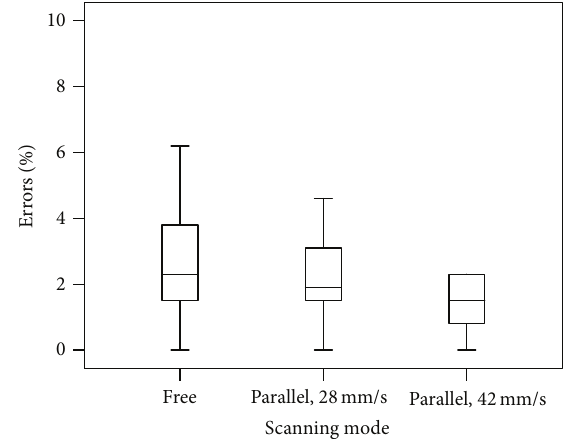
Figure 9: Percentage of false recognition and identifications in the three exploration